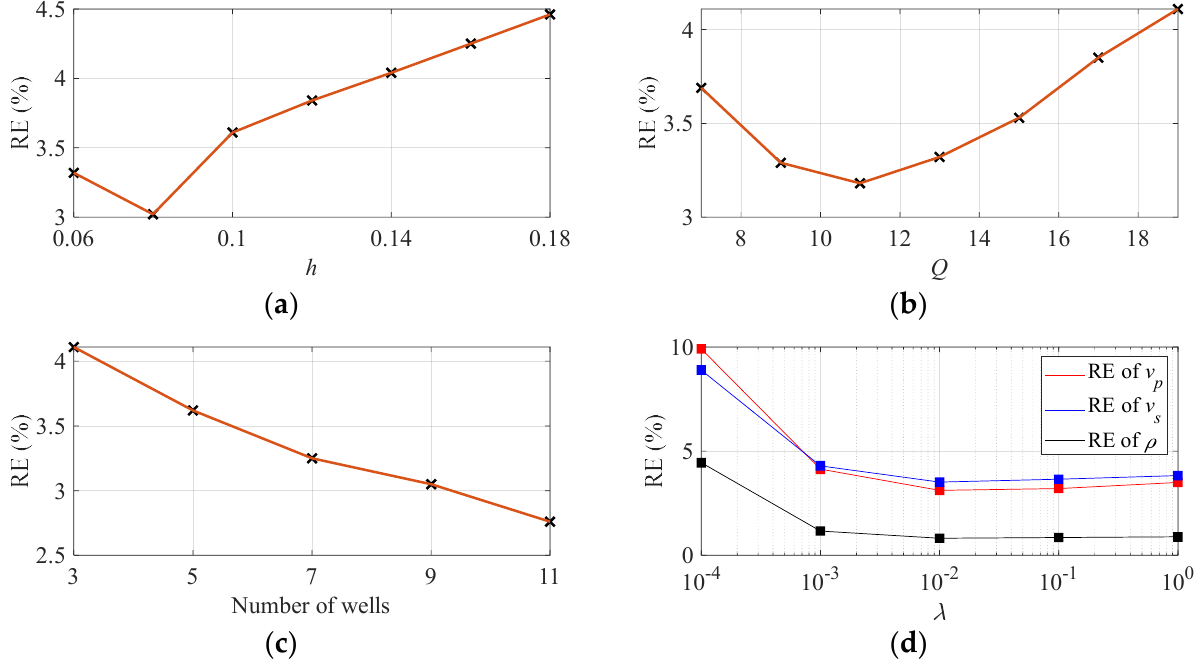
Figure 9. RE variation with ( a ) interpolation hyper-parameter h , ( b ) the number of reference points Q , ( c ) the number of wells, and ( d ) inversion hyper-parameter λ .